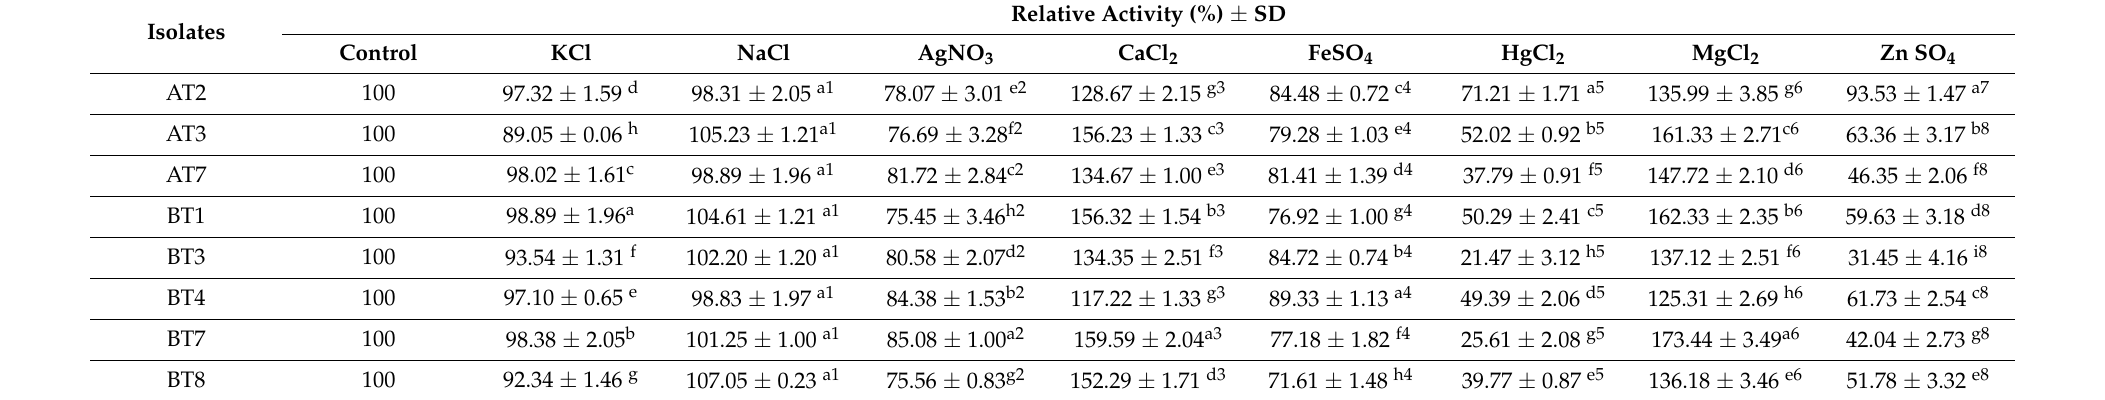
Table 5. Effect of metal ions and inhibitors on chitinase activity of Trichoderma